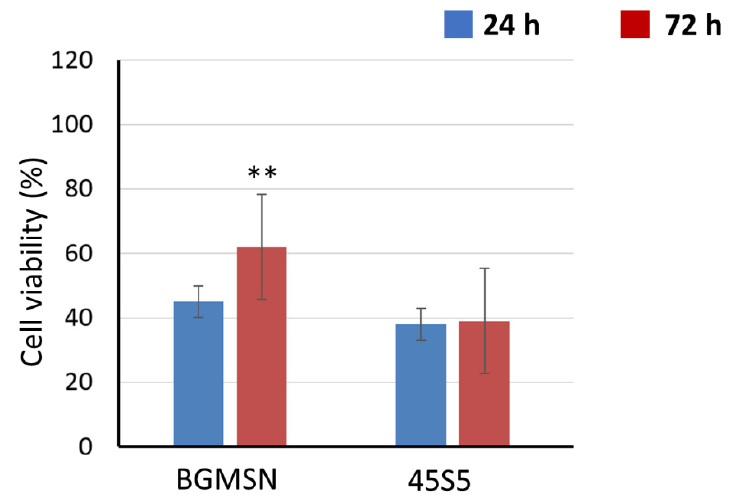
Figure 7. Neutral red (NR) uptake 24 h and 72 h after seeding using MLO-Y4. ** p < 0.05.